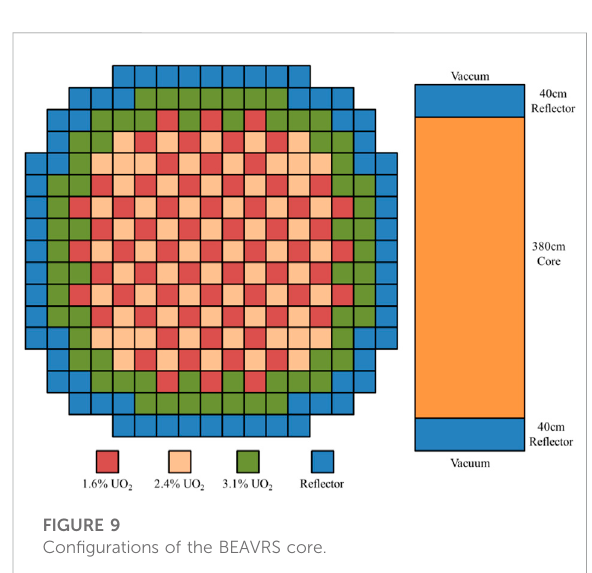
FIGURE 9 Con fi gurations of the BEAVRS